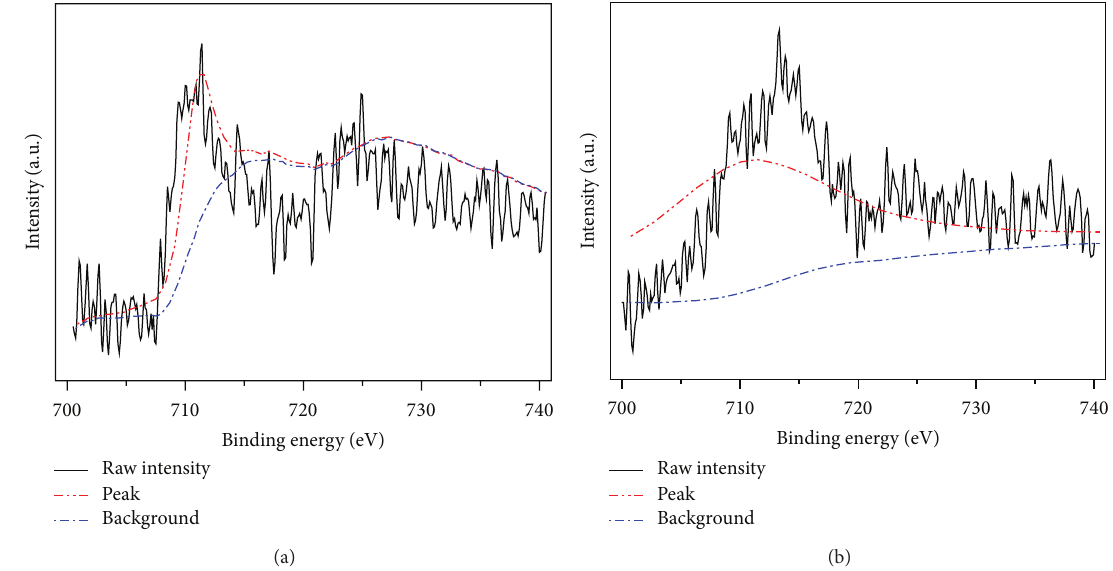
Figure 2: XPS spectra of Fe2p for g-Fe-C 3 N 4 (a) and m-Fe-C 3 N 4 (b).